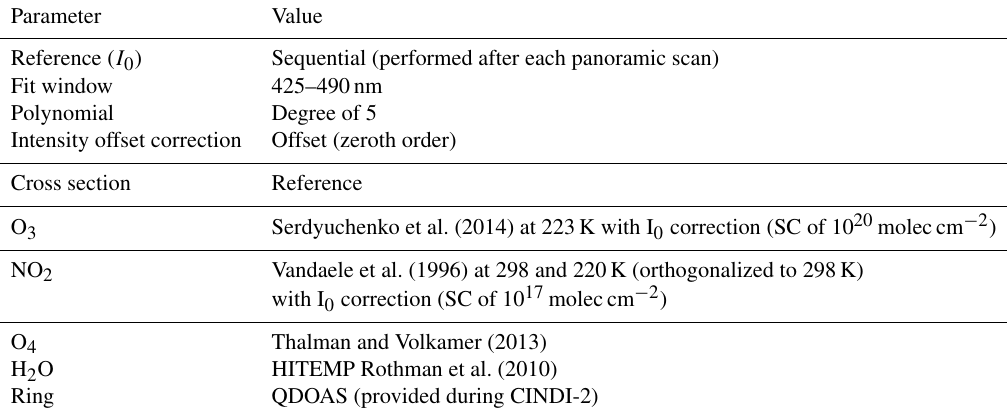
Table 2. DOAS fit settings for NO 2 and O 4